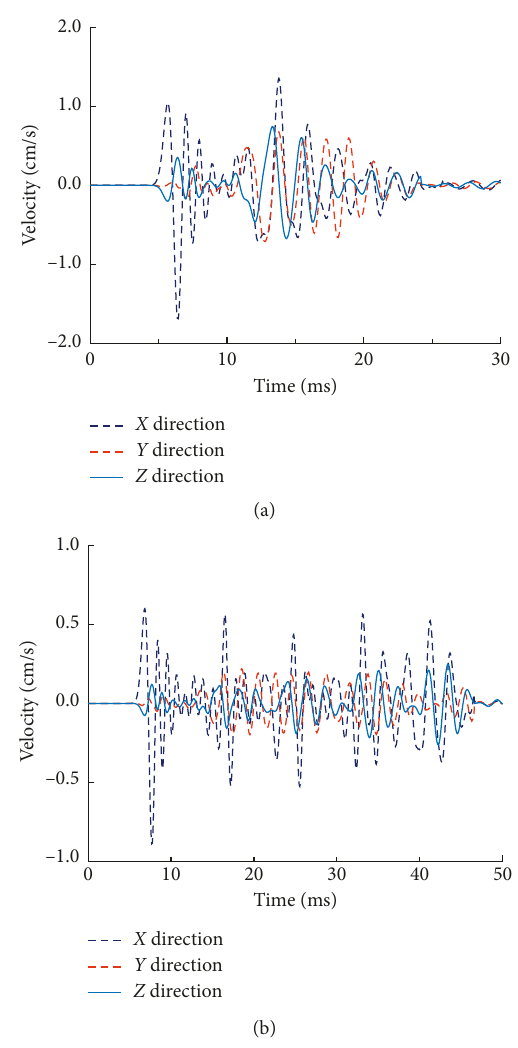
Figure 14: Velocities of (a) 0ms and (b) 8ms